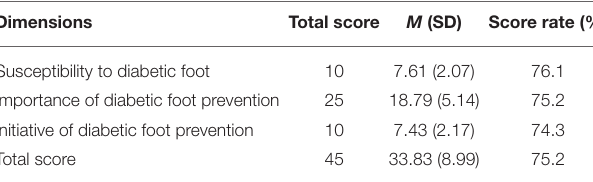
TABLE 3 | Attitude scores of diabetic foot prevention.